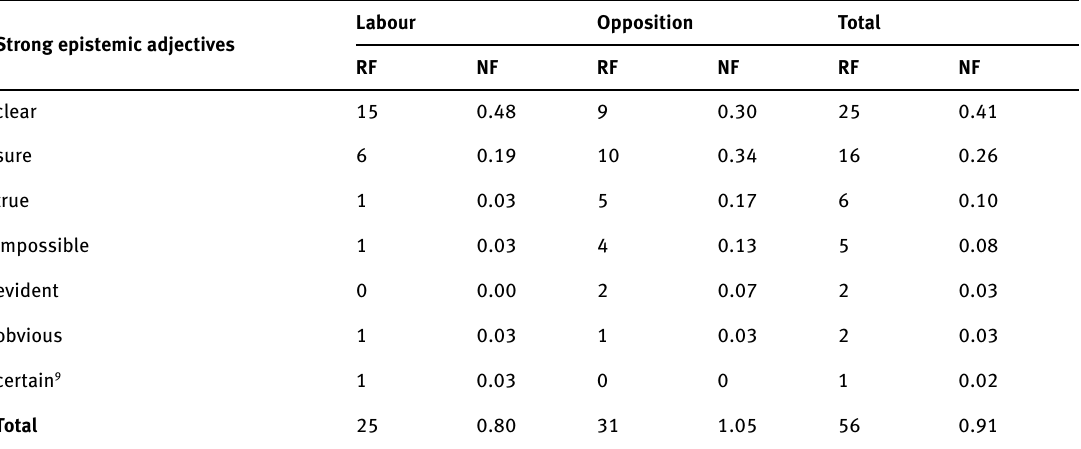
Table 5: Strong epistemic adjectives.